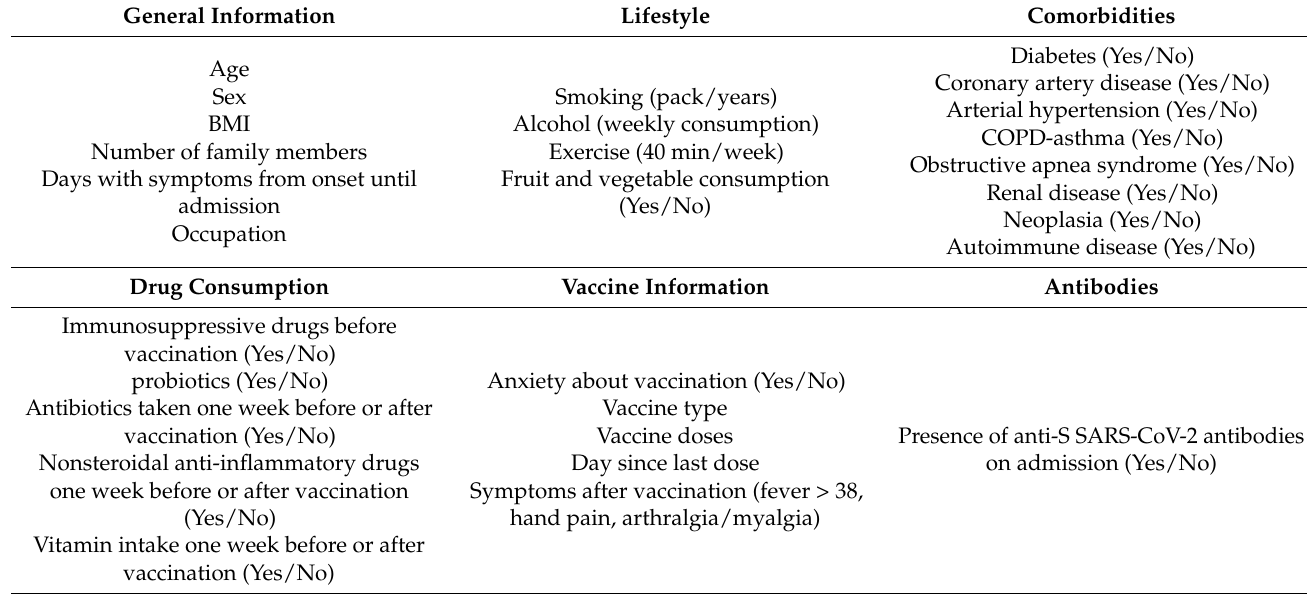
Table 1. The factors that were investigated in the present study in terms of their effect on SARS-CoV-2 IgG S antibody